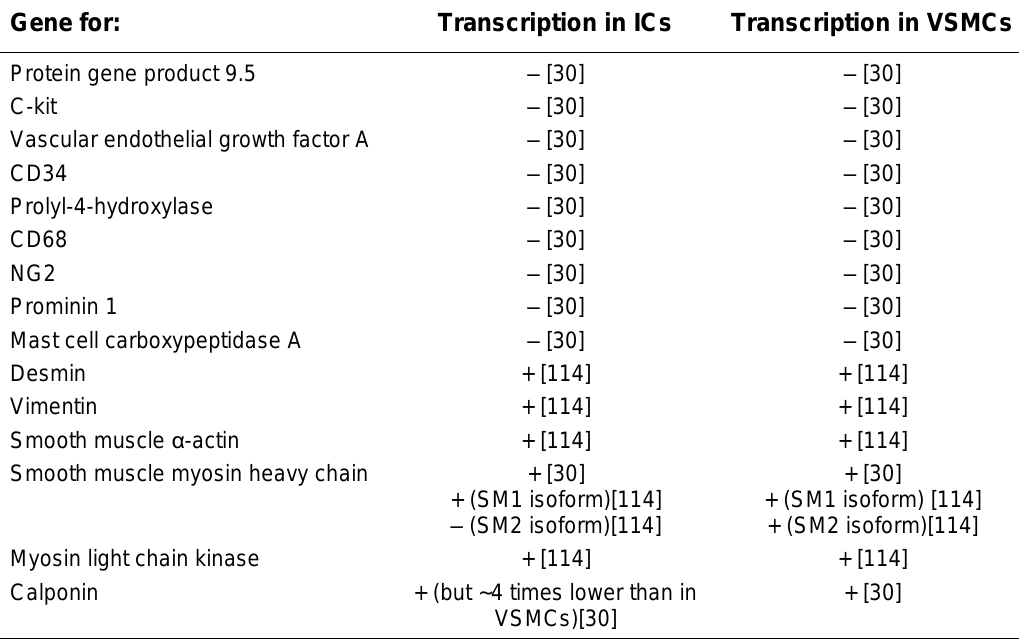
Transcription of Protein Genes by Vascular ICs and